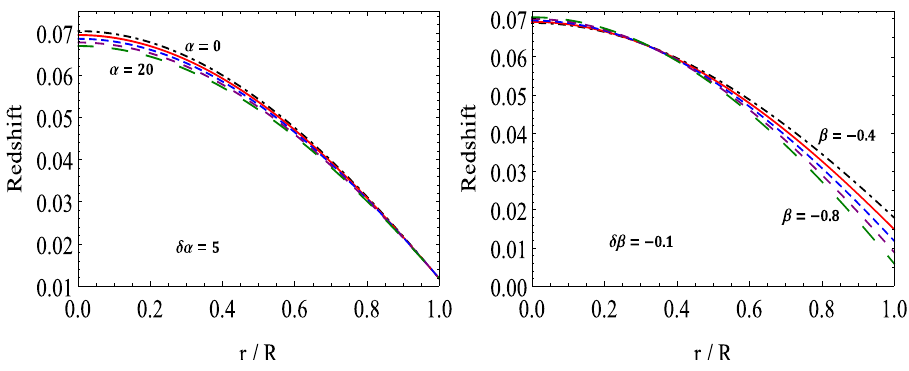
Fig. 7 Variation of gravitational redshift ( z ) versus radial coordinate r / R . The left figure is plotted for fixed β = − 0 . 6 with different α while right figure for fixed α = 5 with different